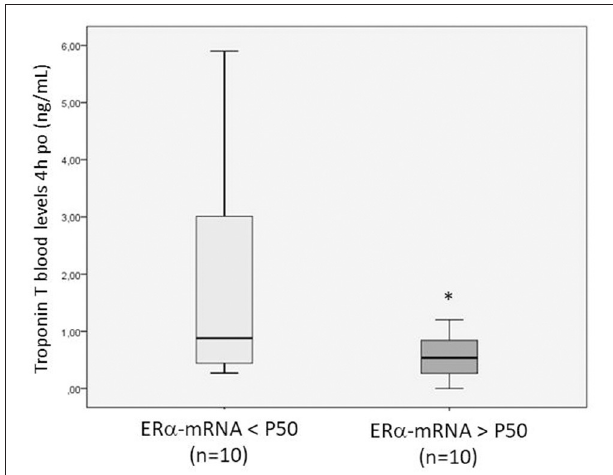
FIGURE 4 | Box plot showing the troponin T blood levels measured 4h post-operatively in patients with ER α -mRNA expression < P50 (light gray) or > P50 (dark gray). The box plot summarizes the minimal, maximal, and median (P50) values and interquartile range. * p = 0.043 between both groups.